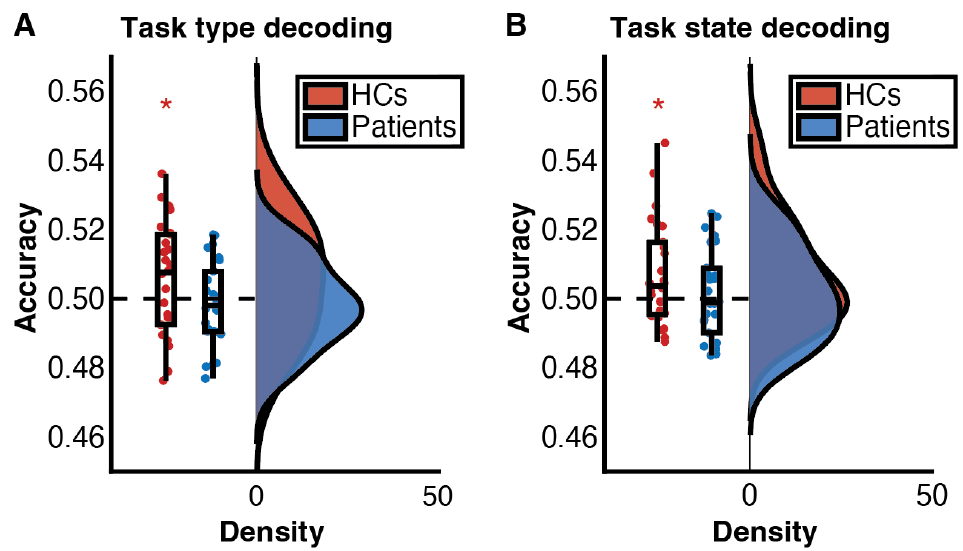
Figure 3. RainCloudPlot [33] of task type decoding ( A ) and task state decoding ( B ). The central line of the boxplot indicates the median of the data while the lower and upper boundary lines reflect the 25th and 75th percentile. Whiskers indicate the non-outlier range (1.5 × interquartile range). Coloured dots represent individuals’ decoding accuracies. The dashed horizontal line denotes the chance-level decoding accuracy. Violin plots show the probability distribution of the decoding accuracy. * p < 0.05.